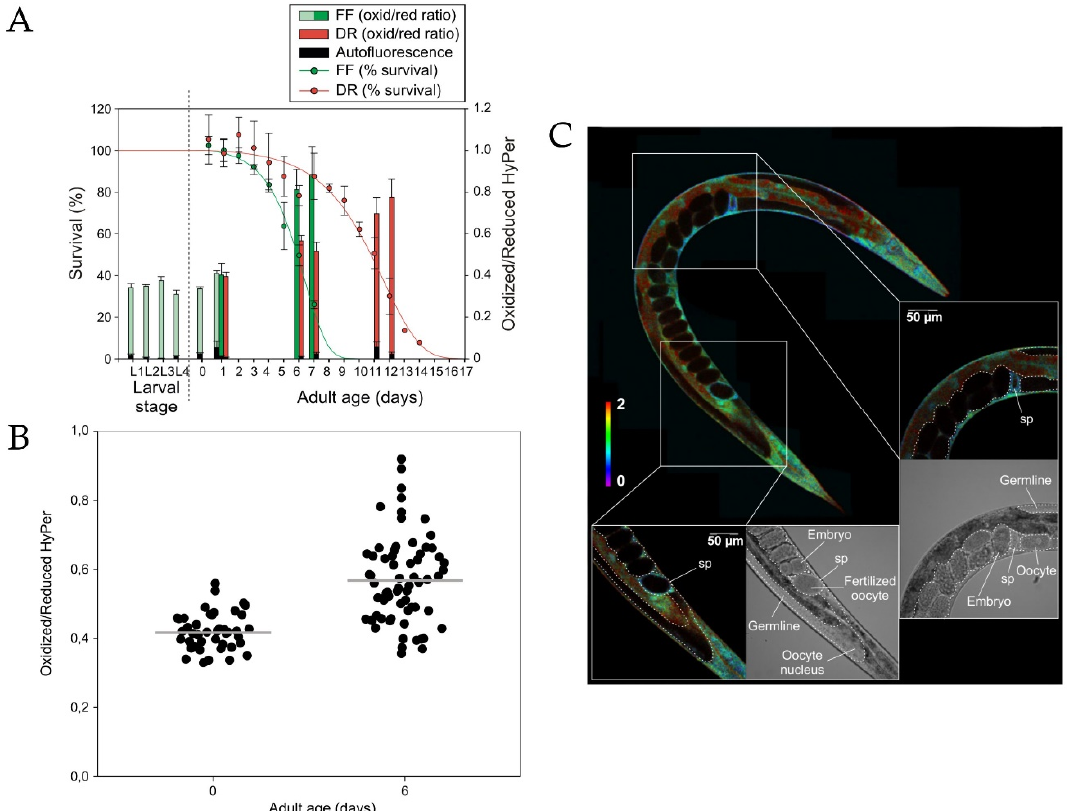
Figure 2. ( A ) Survival (scatter plot with Gompertz fit) and H 2 O 2 levels (stacked bars) during development and aging. Diet-restricted (DR) worms live 76% longer than fully fed (FF) HyPer transgenic worms ( p < 0.0001; log rank test). H 2 O 2 levels did not change significantly during postembryonic development (L1–day 1; light green bars; slope = 0.0004 ± 0.006; p = 0.94; linear mixed model (LMM)). H 2 O 2 levels increase significantly with age in FF (dark green bars; slope = 0.083 ± 0.028; p = 0.0002; LMM) and DR HyPer worms (red bars; slope = 0.030 ± 0.009; p = 0.005). Although FF and DR worms have similar H 2 O 2 levels at the first day of adulthood ( p = 0.78), DR significantly attenuated the age-related increase in H 2 O 2 ( p = 0.016). The portion of autofluorescence in the total ratio value is indicated with black bars. Error bars represent standard error of the mean (SEM). ( B ) Confocal analysis of young and old HyPer worms. Dot plot of mean individual H 2 O 2 levels of young (day 0) and old (day 6) adults scanned with the same laser settings and quantified over the whole worm body; the population mean is indicated by a horizontal line. H 2 O 2 levels, averaged over the population, significantly increase with age. Day 0, 0.42 ± 0.008; day 6, 0.57 ± 0.016; p < 0.01 (paired t test). ( C ) Spatial patterns of GSSG / 2GSH ratios in young (first day of adulthood) Grx1-roGFP2 transgenic adults. Intensity-normalized ratio false-colored image of one Z-level of 3D-stitched worms. The anterior and posterior spermathecae (sp) show low GSSG / 2GSH ratios. Calibration bar indicates the ratio of 525-nm emission after excitation at 405 nm vs. 488 nm. Reprinted by permission from Elsevier: Free Radical Biology & Medicine [120], copyright